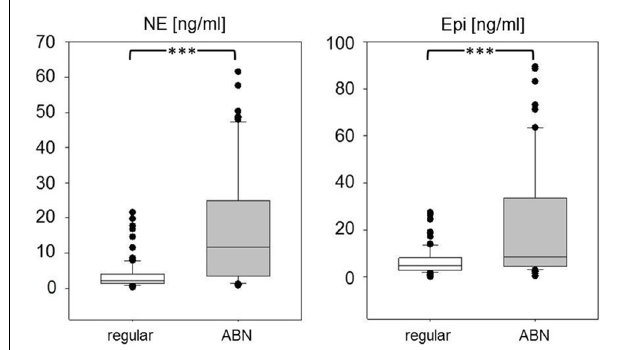
FIGURE 4 | Serum concentrations of norepinephrine (NE) and epinephrine (Epi) in animals with regular experimental course (white boxes) and with clinical and/or procedural abnormalities (ABN, gray boxes). Data are given as medians, 25th/75th percentiles (boxes), 10th/90th percentiles (whiskers), and outliers (circles). Significance marks: ∗∗∗ p < 0.001.